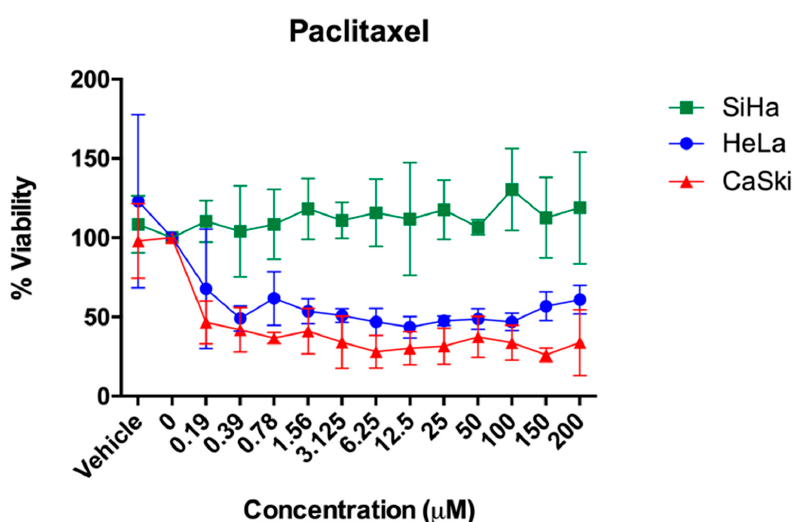
Molecules 2019 , 24 , x FOR PEER REVIEW Figure 4. Cell viability of the compound 1l against SiHa, HeLa, and CaSki. Figure 4. Cell viability of the compound 1l against SiHa, HeLa, and CaSki.